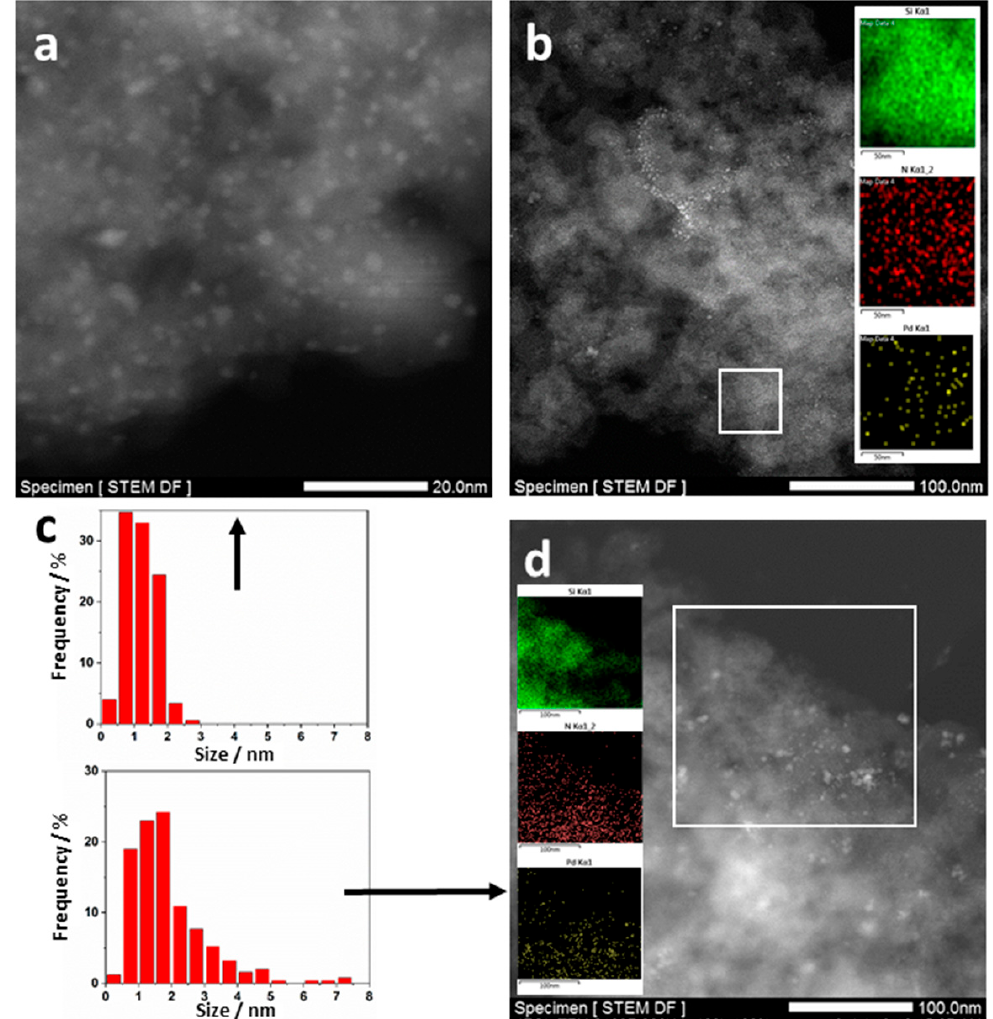
Figure 3. ( a ) HAADF-STEM image of the Pd NPs-UVM-7 / PDA- 1 catalyst. ( b ) HAADF-STEM image of the Pd NPs-UVM-7 / PDA- 1 catalyst including an EDX mapping of the selected area showing the Si, N, and Pd distribution. ( c ) Histograms showing the Pd NPs size distribution (top and bottom graphics correspond to the Pd NPs-UVM-7 / PDA- 1 and Pd NPs-UVM-7 / PDA- 2 catalysts,